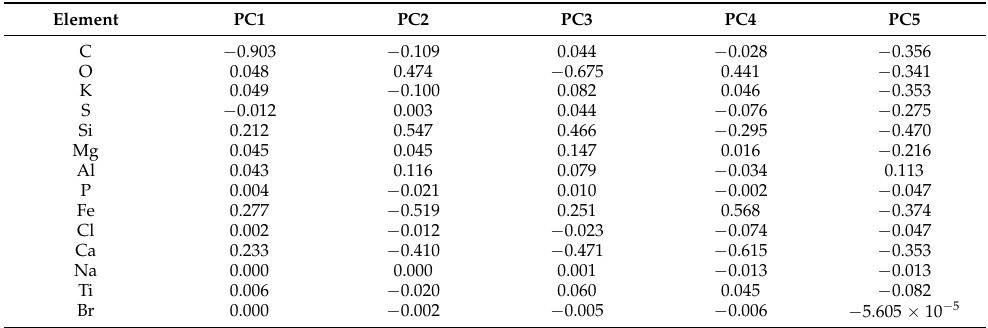
Table 3. Loadings of the Principal Components extracted for the chemical elements (in percentages) found on samples of the lichen Xanthoria parietina collected along an urban–rural gradient in the city of L’Aquila (Central Italy).